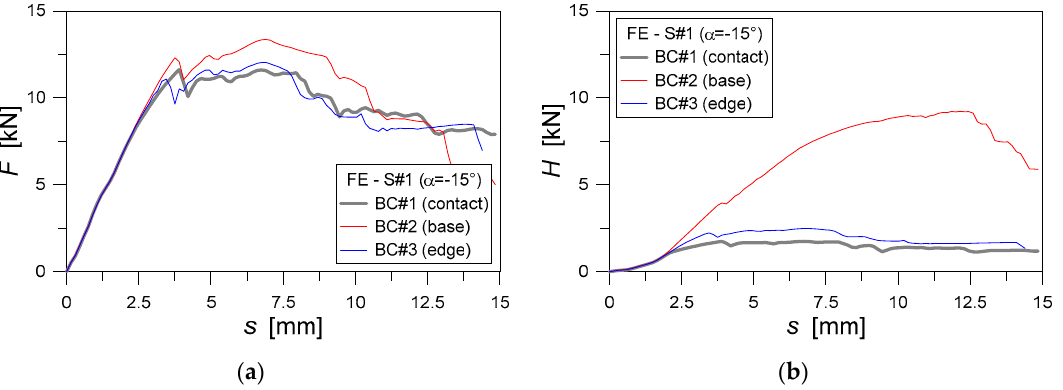
Figure 18. Analysis of boundary effects on the PO numerical response of TTC joints with inclined STSs. In evidence, the ( a ) vertical and ( b ) horizontal base reaction force, as a function of the measured slip for a selected TTC joint (ABAQUS/Explicit).